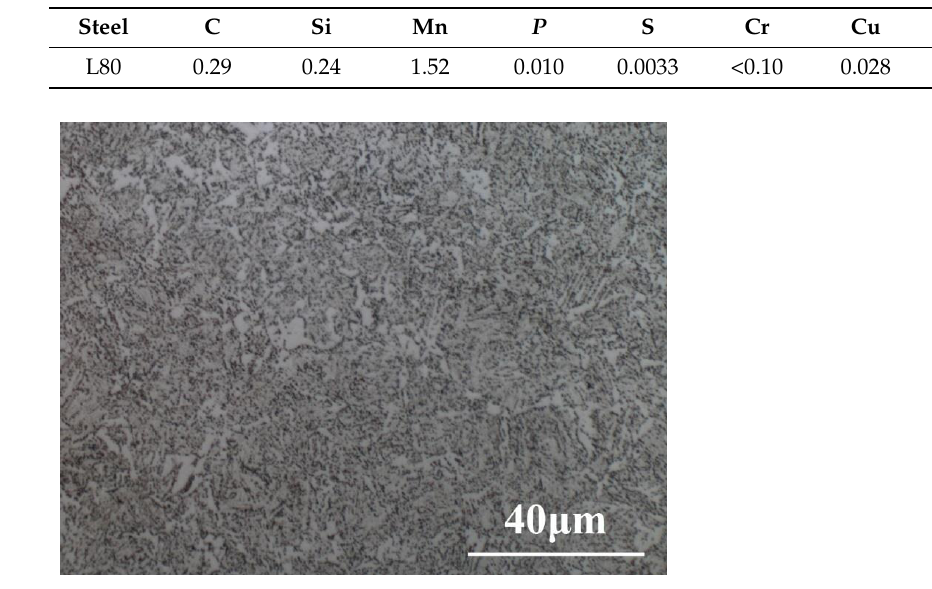
Figure 1. Microstructure of L80 steel.